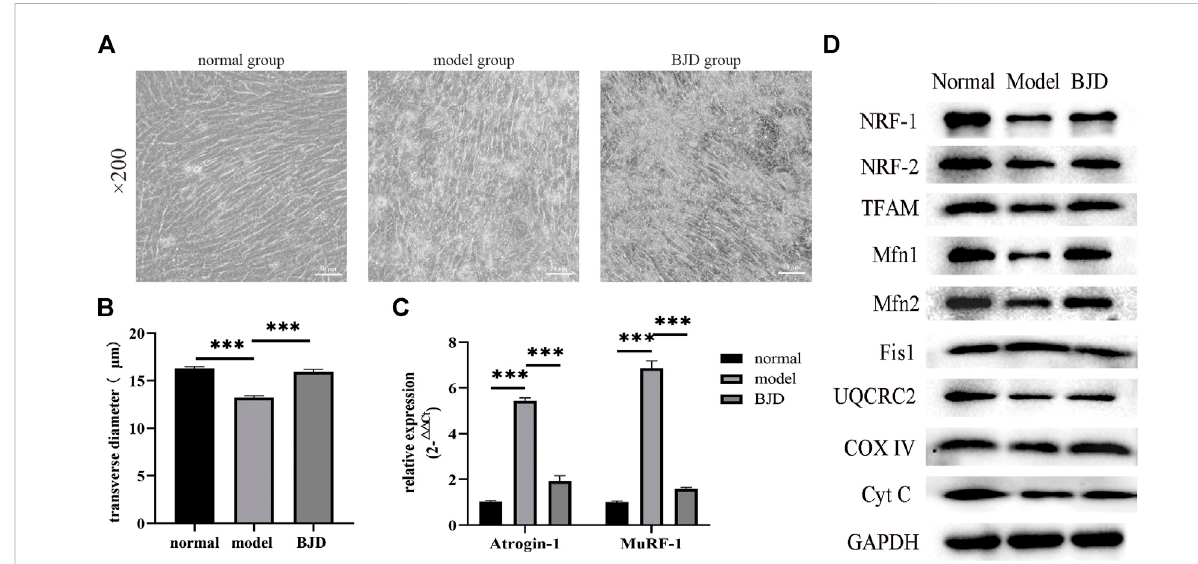
FIGURE 6 BJD prevented LCM-induced myotube atrophy in C2C12 cells. (A) The morphological changes of myotubes in C2C12 cells (×200magni fi cation;scalebar:50 µm). (B) ThetransversediametersofmyotubesinC2C12cells(µm, n =3). (C) Therelativeexpressionsofatrogin-1 and MuRF-1 were detected by qPCR, with ß -actin used as an internal gene. (D) The relative expressions of proteins related to mitochondrial function were detected by western blotting in vitro , with GAPDH used as a loading control. The data are presented as the mean ± SD. *** p <